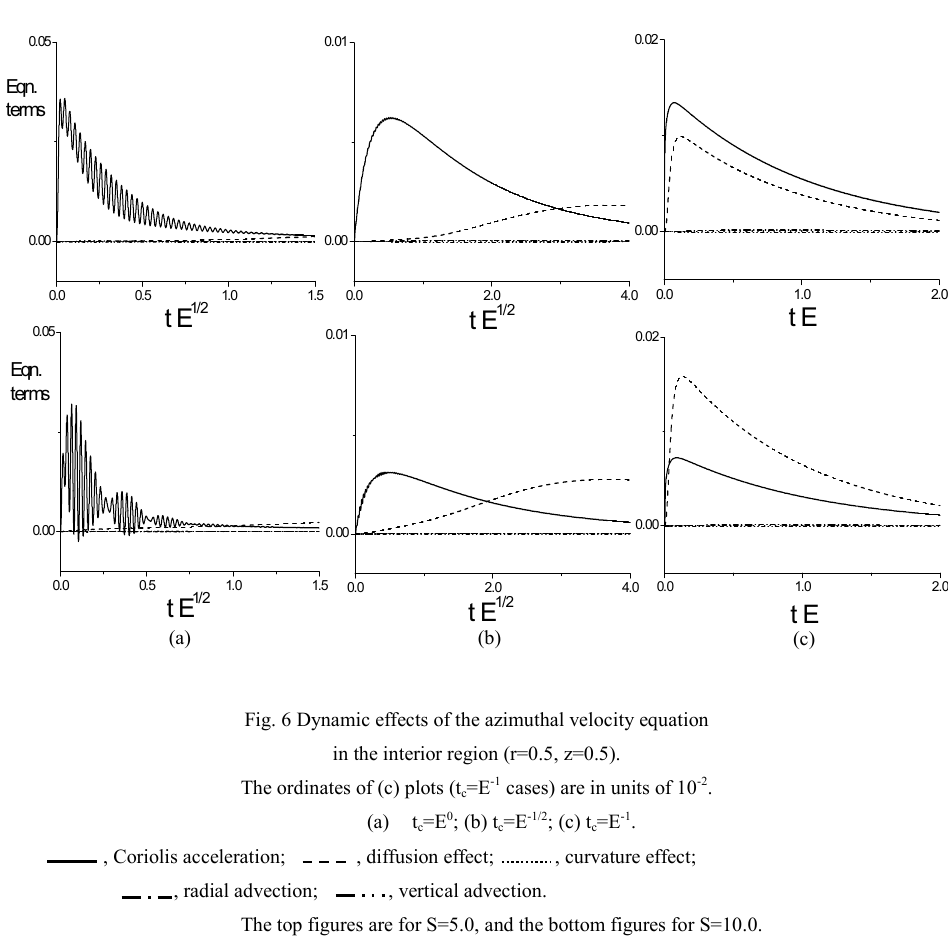
The top figures are for S=5.0, and the bottom figures for S=10.0.